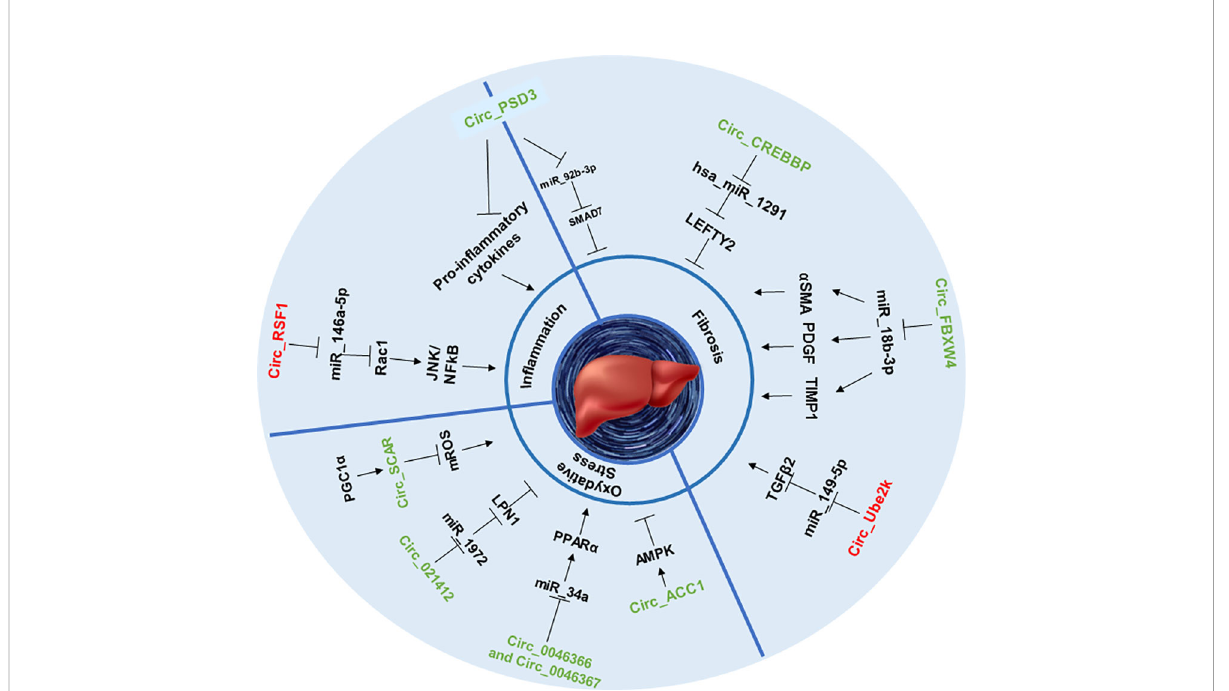
FIGURE 2 CircRNAs involved in NASH stage. This fi gure represents the effect of circRNAs in in fl ammation, fi brosis and oxidative stress through sponging speci fi c miRNAs that can upregulate or downregulate speci fi c proteins and signaling